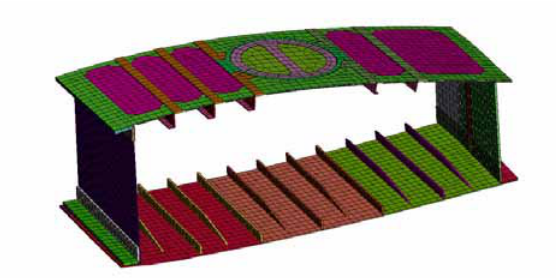
Fig. 4. Detail of the FE model of the designed semi-shell wing structure